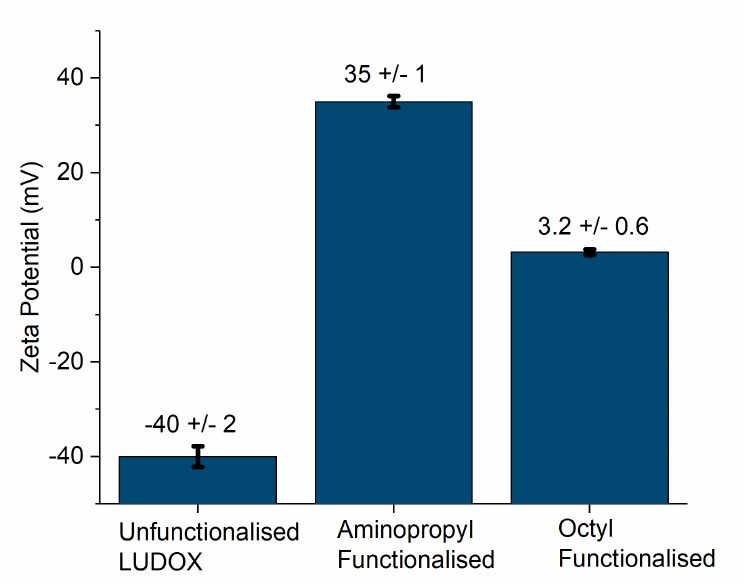
Figure A3. Zeta potential of initial and functionalised AS40 Ludox in MilliQ water suspension after dialysis.